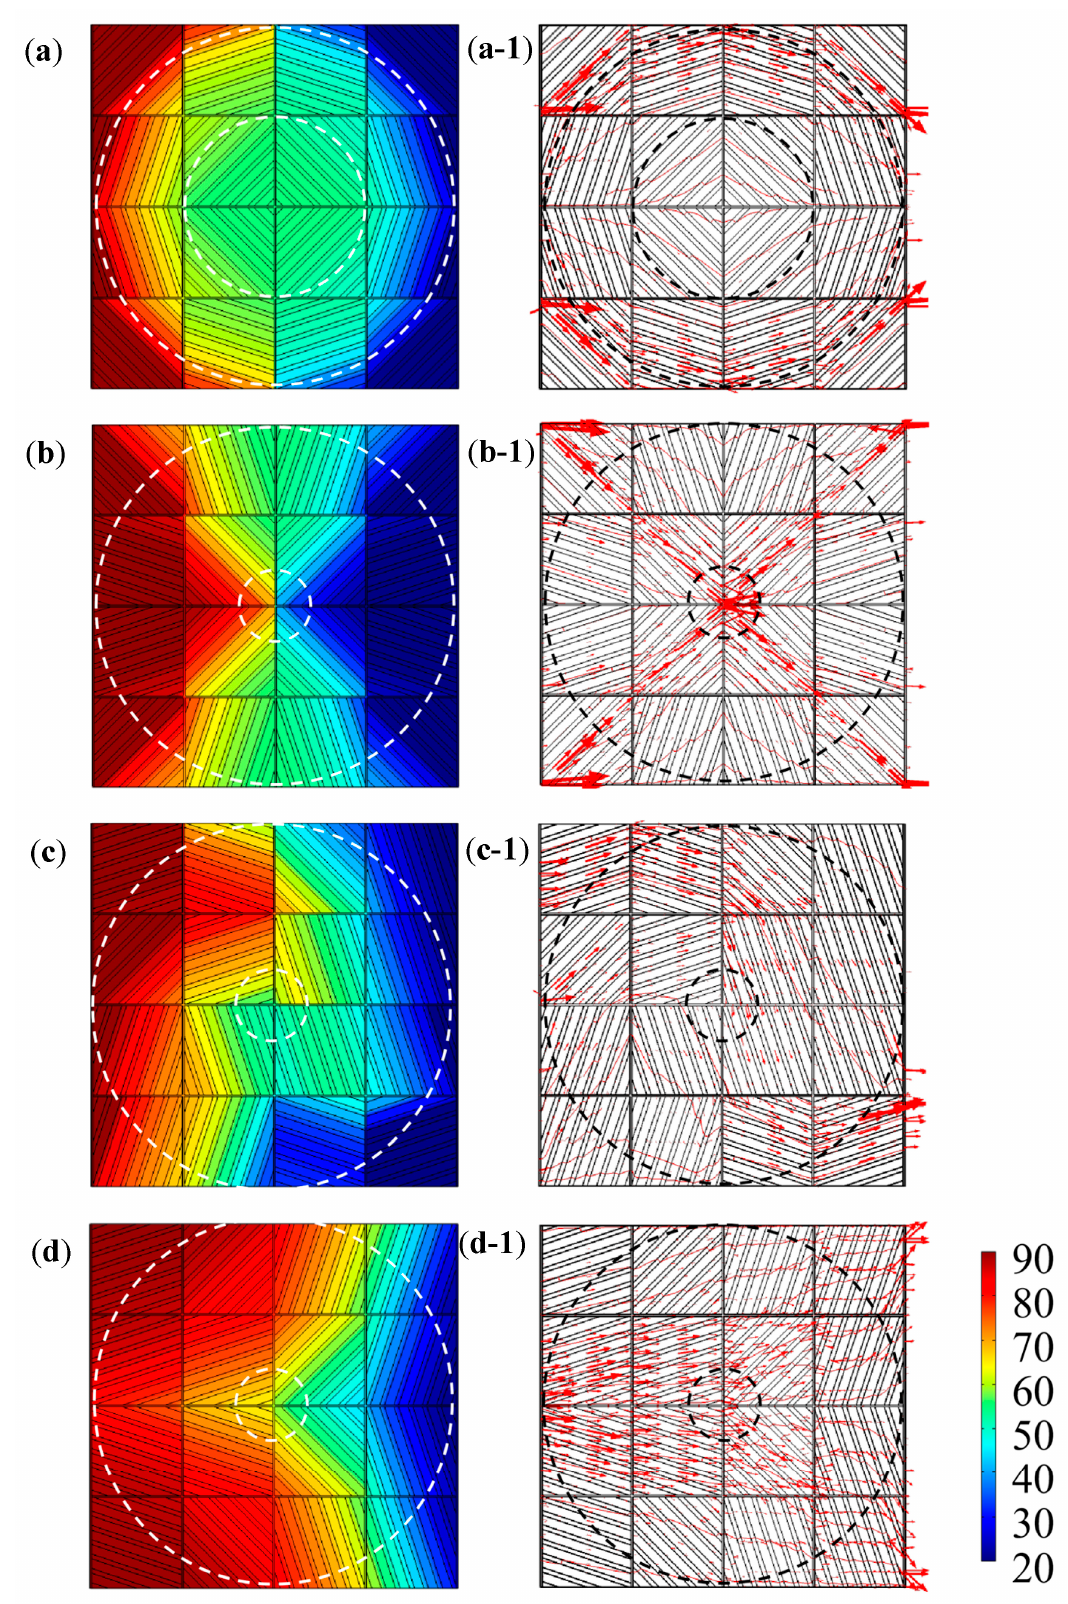
Figure 9. The simulation results of temperature fields ( a – d ) and heat ‐ flow transfer directions ( a ‐ 1 – d ‐ 1 ) in convertible meta ‐ structures for the thermal manipulations of thermal cloak ( a , a ‐ 1 ), thermal concentration ( b , b ‐ 1 ), thermal rotation ( c , c ‐ 1 ), and thermal dispersion ( d , d ‐ 1 ).